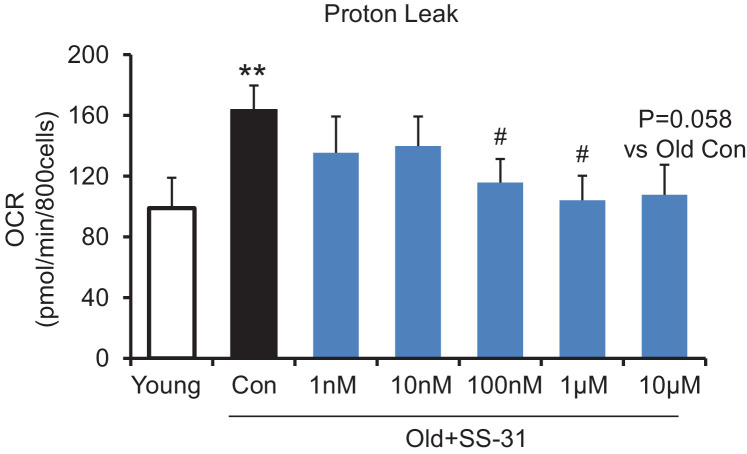
SS-31 reaches its inhibitory effect on proton leak suppression at low concentrations.SS-31 decreased the mitochondrial proton leak. N = 6–14 mice in each group. **p<0.01 vs young, #p<0.05 vs old controls. One-way ANOVA with Fisher’s LSD test was applied.